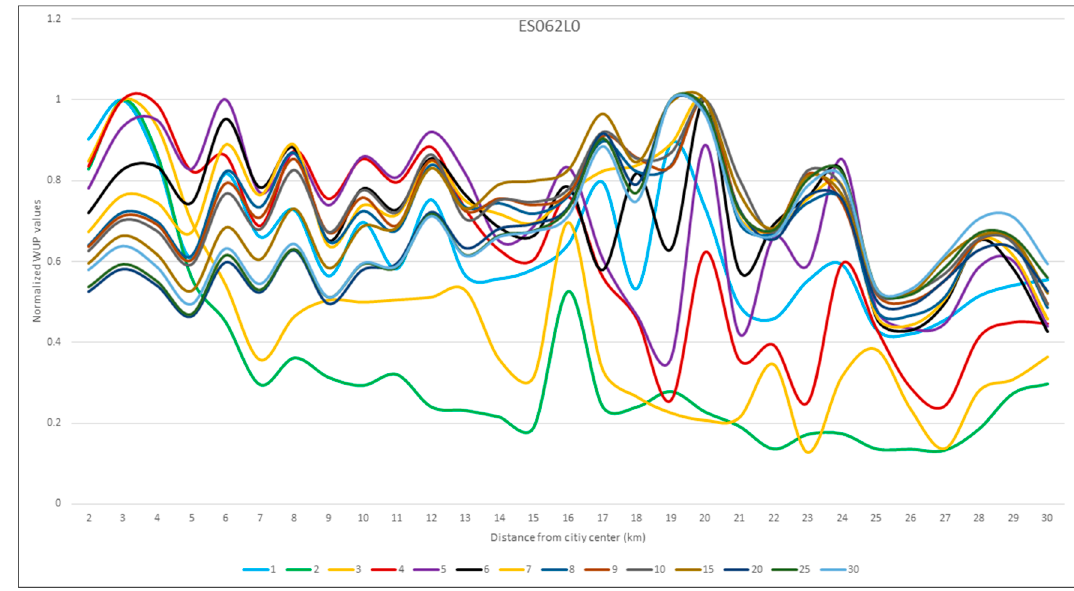
Figure 5. Normalized WUP values as a function of distance to the city center, calculated for increasing horizons of perception for the city of Sanlucar de Barrameda, Spain.